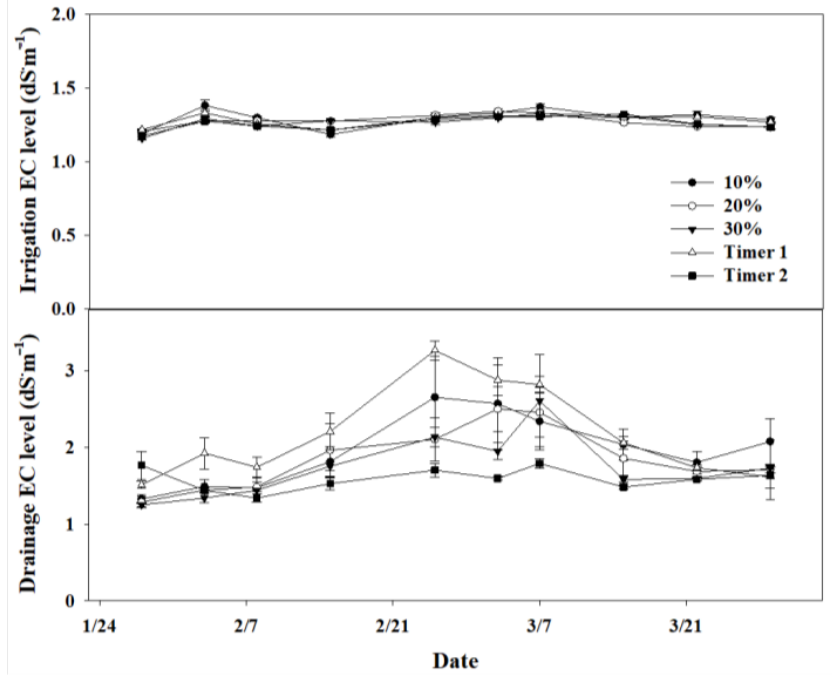
Figure 2. Irrigation and drainage EC levels of strawberry ‘Kuemsil’ affected by the nutrient solution supplying system using different drainage rate levels and timings (Drainage rate 10%, 20%, or 30%; Timer 1, timer set for 4 applications daily; Timer 2, timer set for 6 applications daily). Vertical bars indicate standard errors of the means ( n = 3).